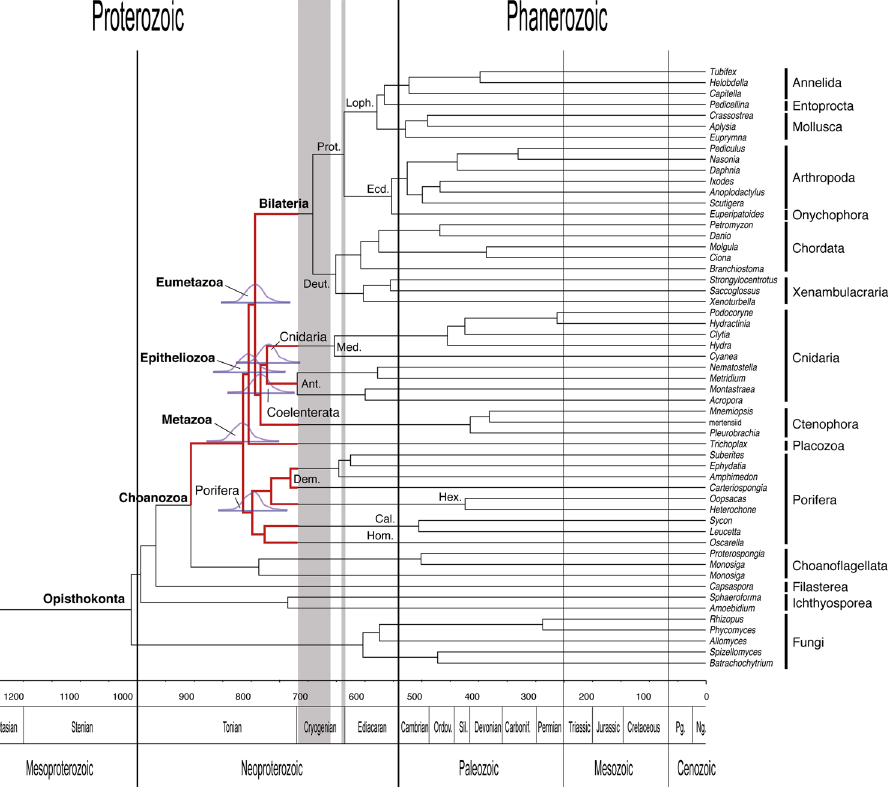
Figure 4. Time-calibrated phylogeny of animals. Phylogeny of crown-Opisthokonta obtained by Philippe et al . 18 , time-calibrated using Calibration set A , an autocorrelated relaxed clock model, and 1000 Ma root age prior (see text). Gray areas indicate Sturtian (left) and Marinoan (right) glaciations 21 . Thick red branches highlight pre-Snowball Earth radiation of animal lineages. Bars at selected deep nodes represent 95% CrIs; above them density plots highlighting the frequency of different age estimates around the mean are shown (produced with custom python and R scripts developed by S. Vargas). Ages in million years before present (Ma). Stratigraphic abbreviations: Ordov., Ordovician; Sil., Silurian; Carbonif., Carboniferous; Pg., Palaeogene; Ng., Neogene. Taxon abbreviations: Hom., Homoscleromorpha; Cal., Calcarea; Hex., Hexactinellida; Dem., Demospongiae; Ant., Anthozoa; Med., Medusozoa; Deut., Deuterostomia; Prot., Protostomia; Ecd., Ecdysozoa; Loph.,